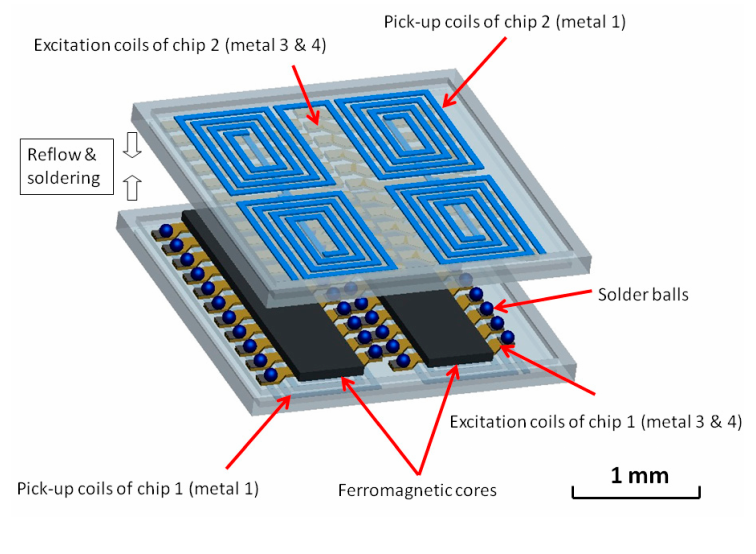
Figure 11. Schematic of the proposed flip-chip micro-fluxgate